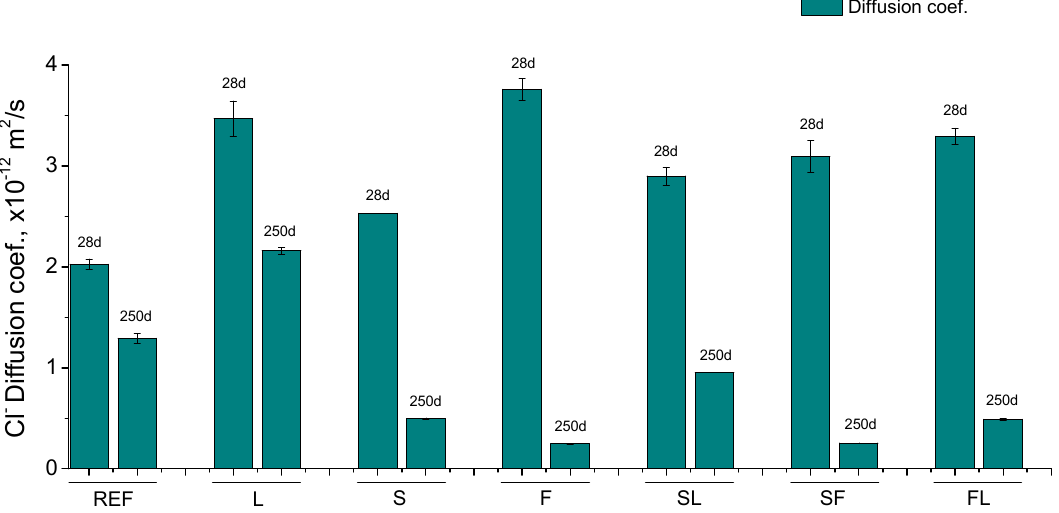
Figure 5. Steady-state chloride diffusion coefficient results obtained for the analyzed mortars.